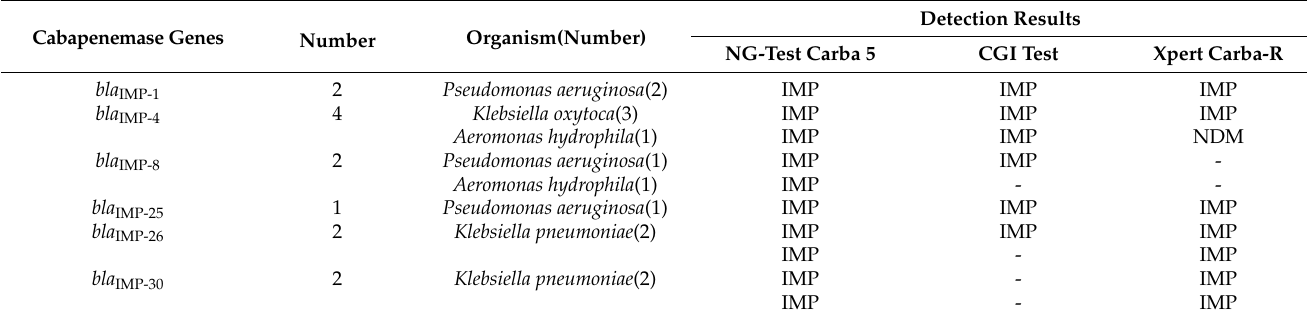
Table 3. Detection results of IMP variants by different methods.